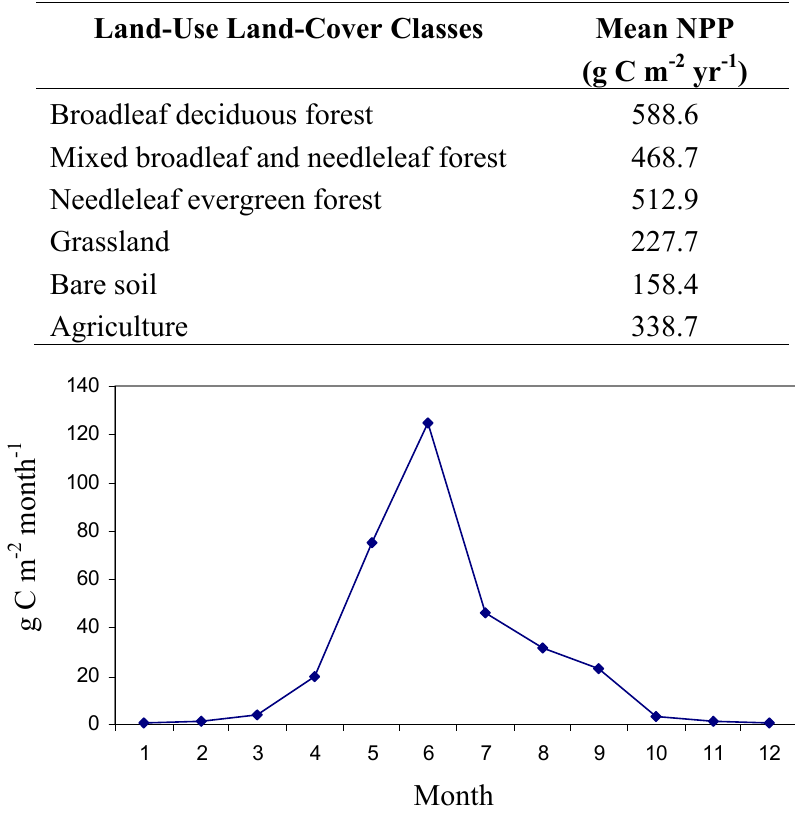
Table 1 . Annual net primary productivity (NPP) of major land covers and land uses of Seyhan watershed according to the CASA algorithm.